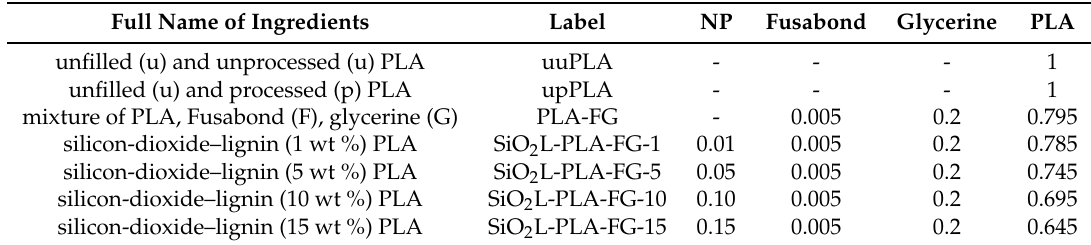
Table 1. Labels and proportions of ingredients of prepared nanocomposite samples in mass